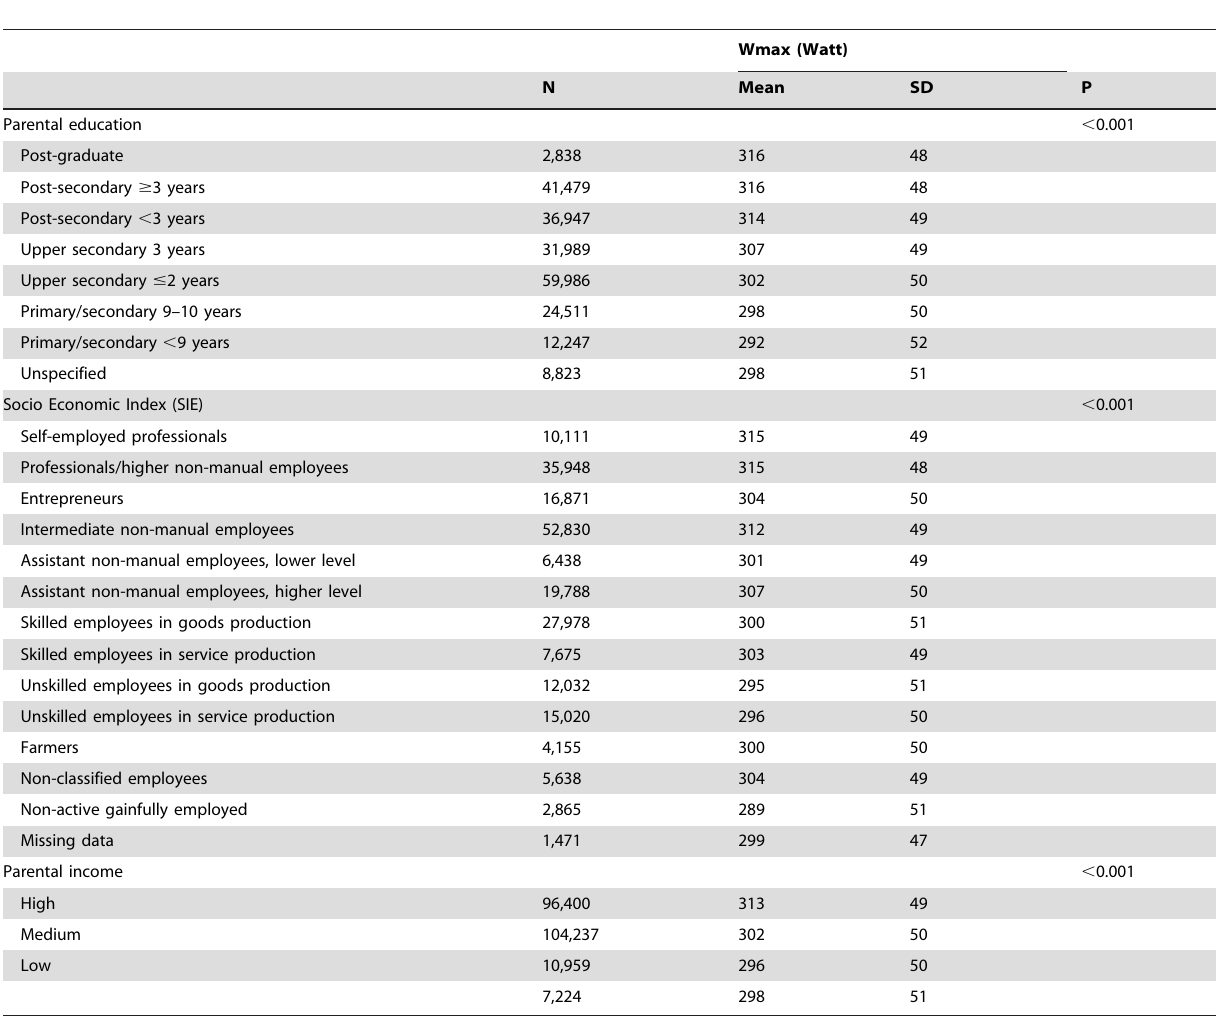
Table 6. Maximal exercise capacity by parental characteristics (univariate